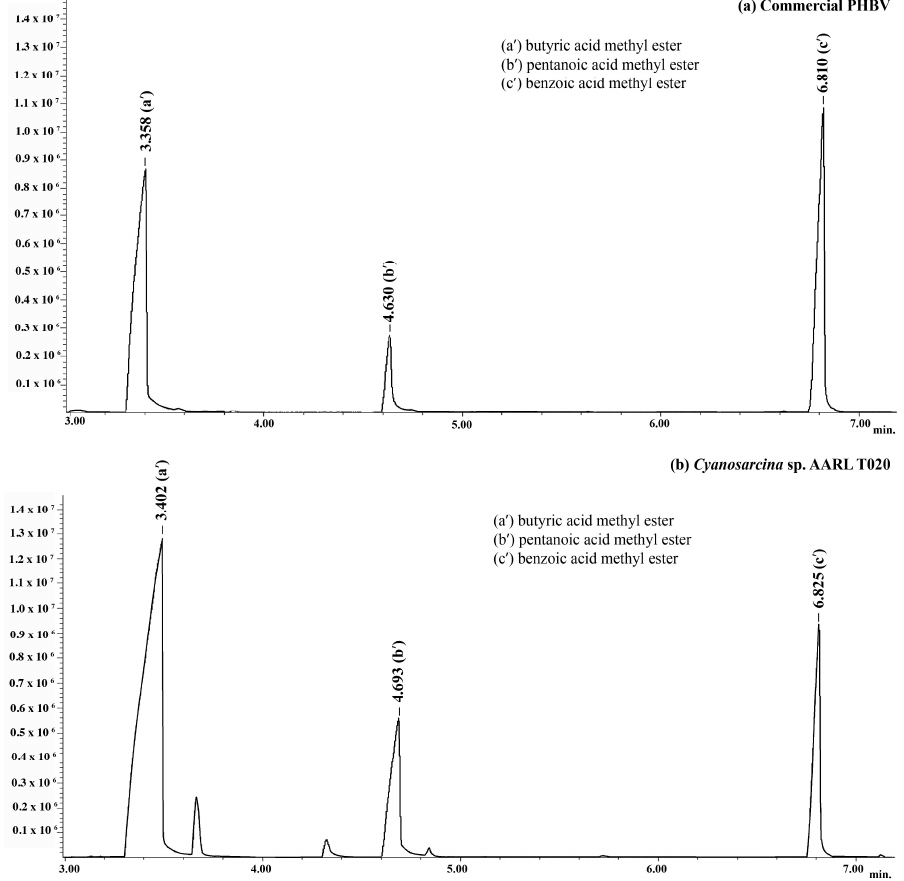
Figure 2. GC spectra of PHBV obtained from ( a ) Cyanosarcina sp. AARL T020 compared with ( b ) the commercial standard PHBV.